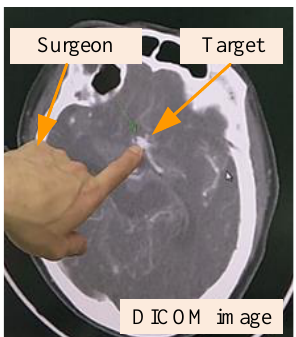
Figure 10. Manually identify the target position.